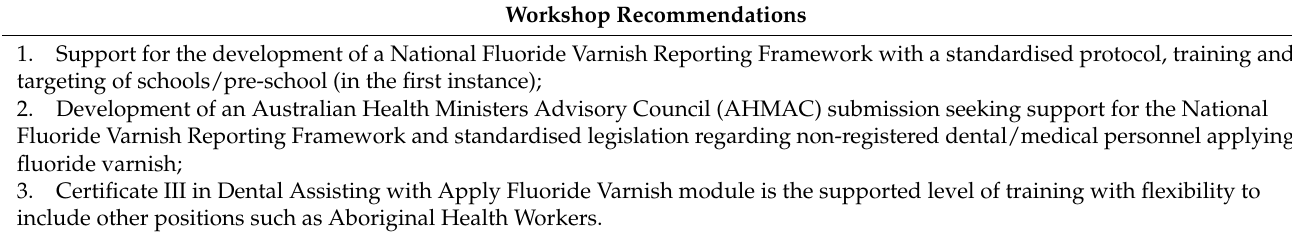
Table 3. Key consensus recommendations from the National Fluoride Varnish Consensus Workshop